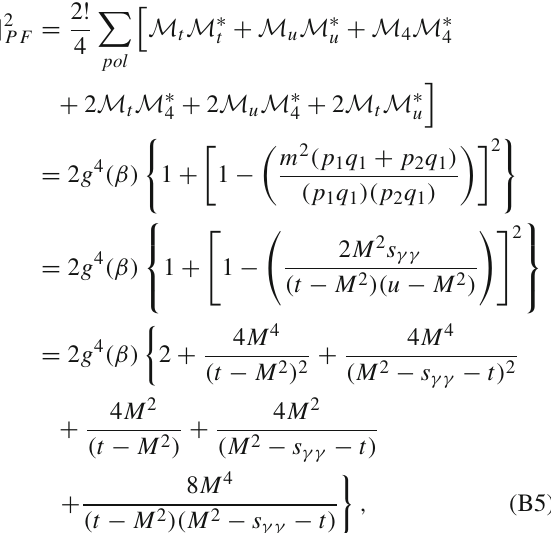
Fig. 30 a Three-point vertex representing the tree-level interaction of scalarmonopoles(dashedlines)withphotons(wavylines). b Thequark- photon three point vertex as in ordinary QED. The corresponding Feyn- manrulesaregivenin(B10),where g (β) isthe(ingeneral β -dependent) monopole magnetic charge